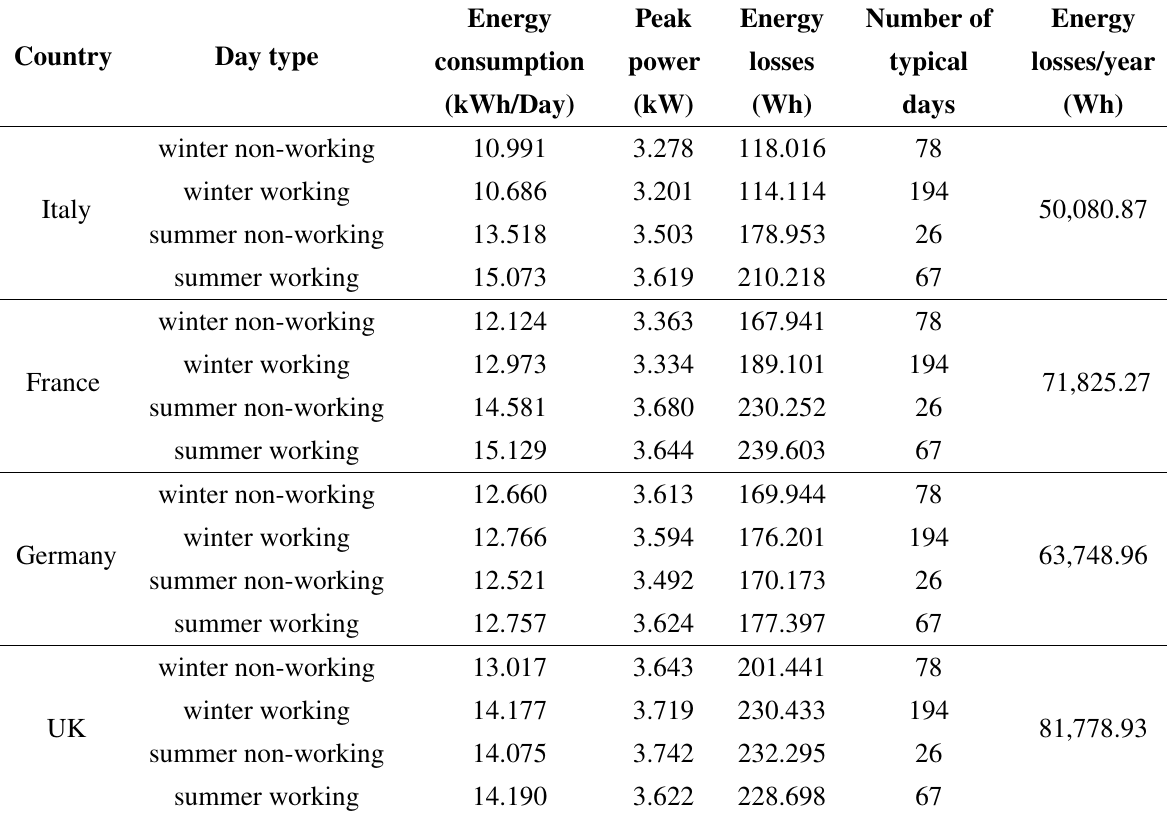
Table 2. House energy losses per country-reference scenario.